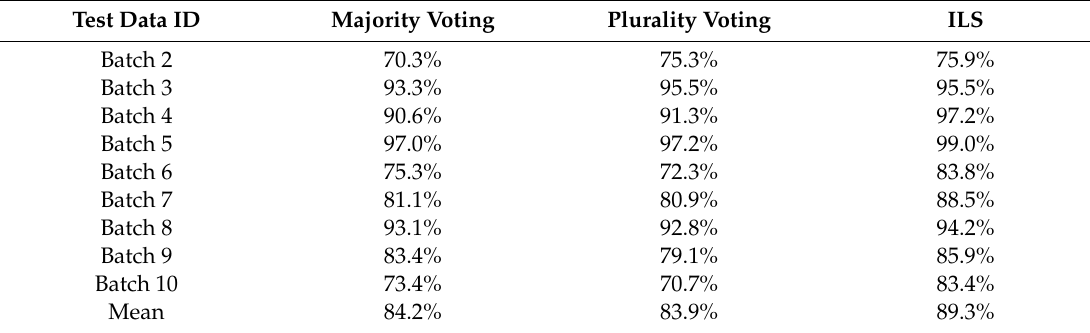
Table 10. Classification Accuracy for di ff erent